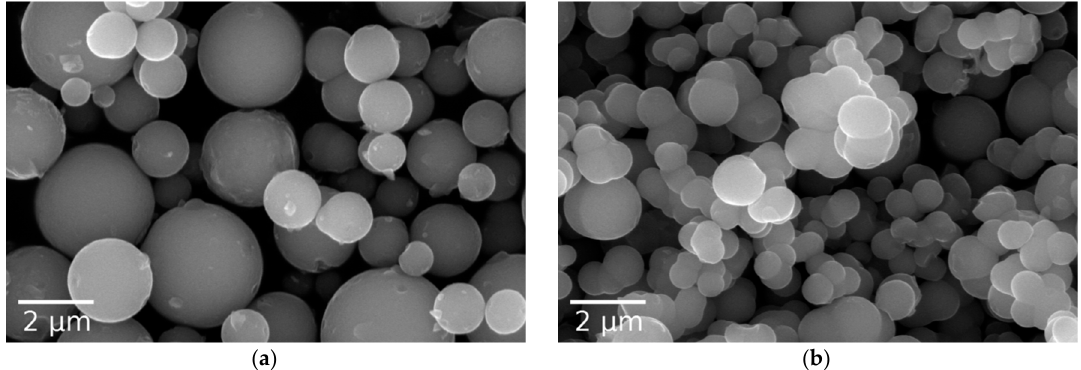
Figure 1. SEM images of the microspheres synthesized without the addition of NaOH, ( a ) h = 2 and ( b ) h = 6.